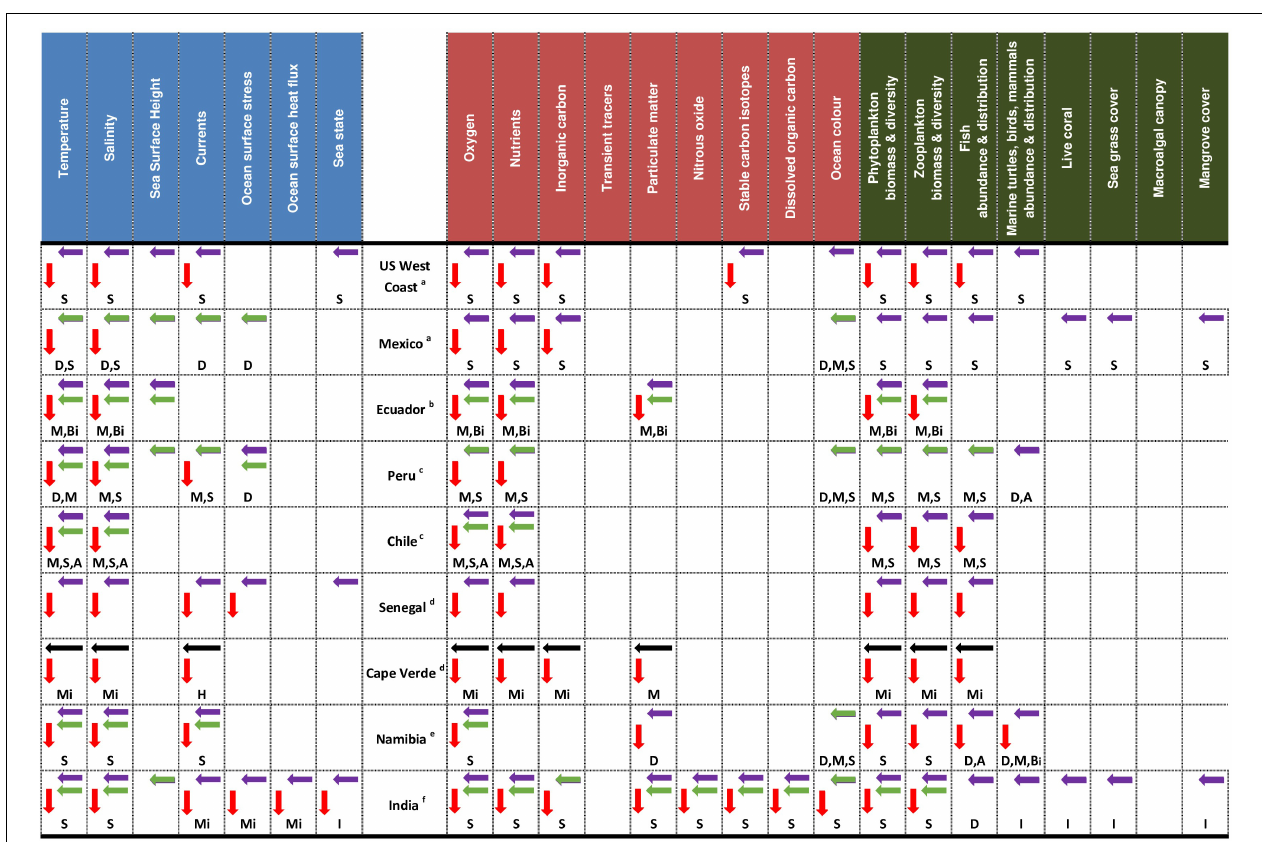
FIGURE 10 | Spatiotemporal resolution and geographical coverage of all essential ocean variables (EOVs) in the oxygen minimum zone (OMZ) regions. Definition of symbols used: A annual, Bi biannual, S seasonal, M monthly, W weekly, D daily, H hourly, Mi minutes, and I irregular. Arrows indicate: mesoscale (black), regional (green), coastal (purple), depth